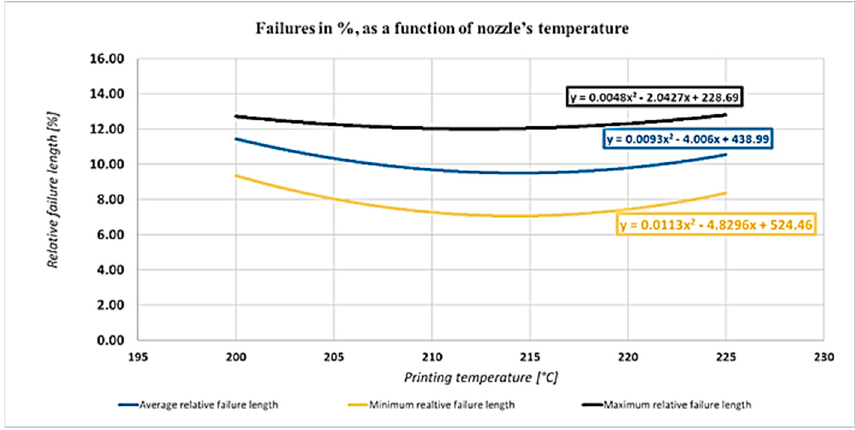
Figure 9. Effect of the printing temperature on the relative failure length.